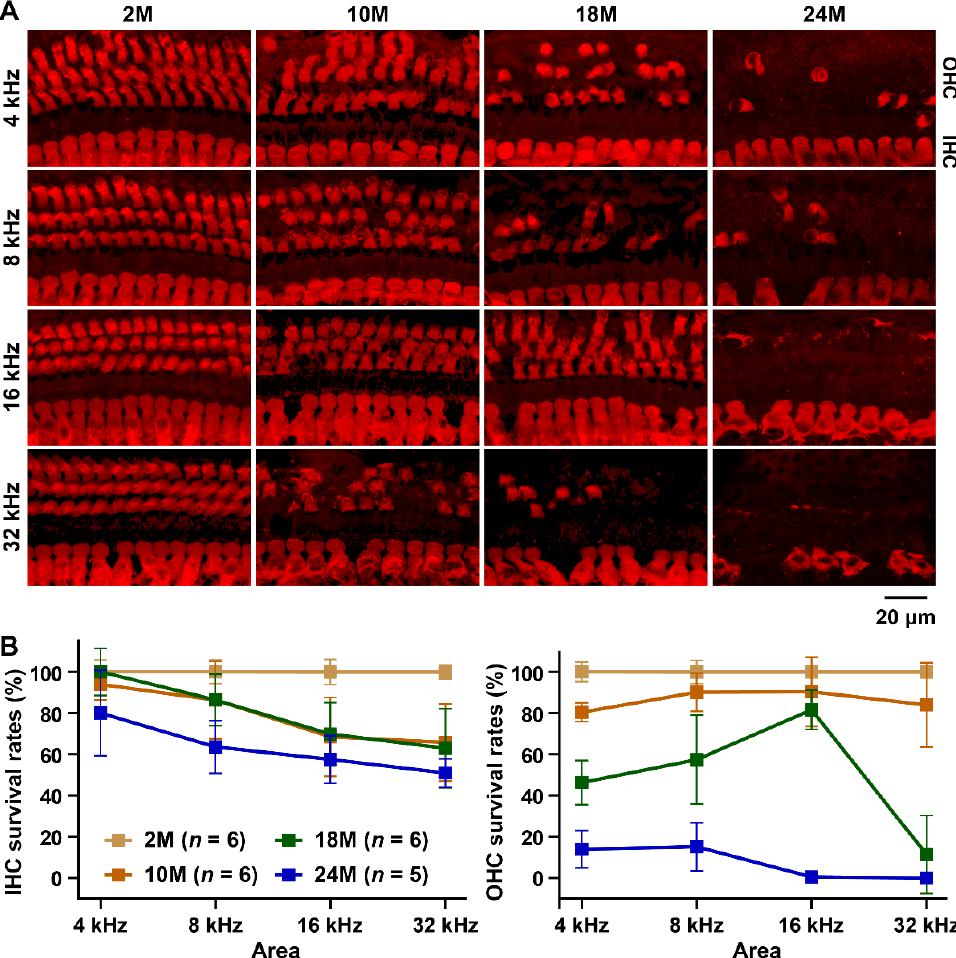
Figure 3. Decrease in the IHC and OHC survival in aging B6 strain ( A ) Representative confocal images of MYO6-positive IHC and OHC signals within the 4, 8, 16, and 32 kHz areas of the cochlea from male mice of the B6 strain at 2, 10, 18, and 24 months of age. ( B ) Percentage of surviving IHCs and OHCs at the 4, 8, 16, and 32 kHz-corresponding areas in the cochlea of male mice of the B6 strain at 2, 10, 18, and 24 months of age. The means (squares) and SD (error bars) of the IHC and OHC survivors are shown in each line graph. The mean numbers (Figure 2) of IHCs and OHCs from each area in the B6 mice at 2 months of age were assigned an arbitrary value of 100%.